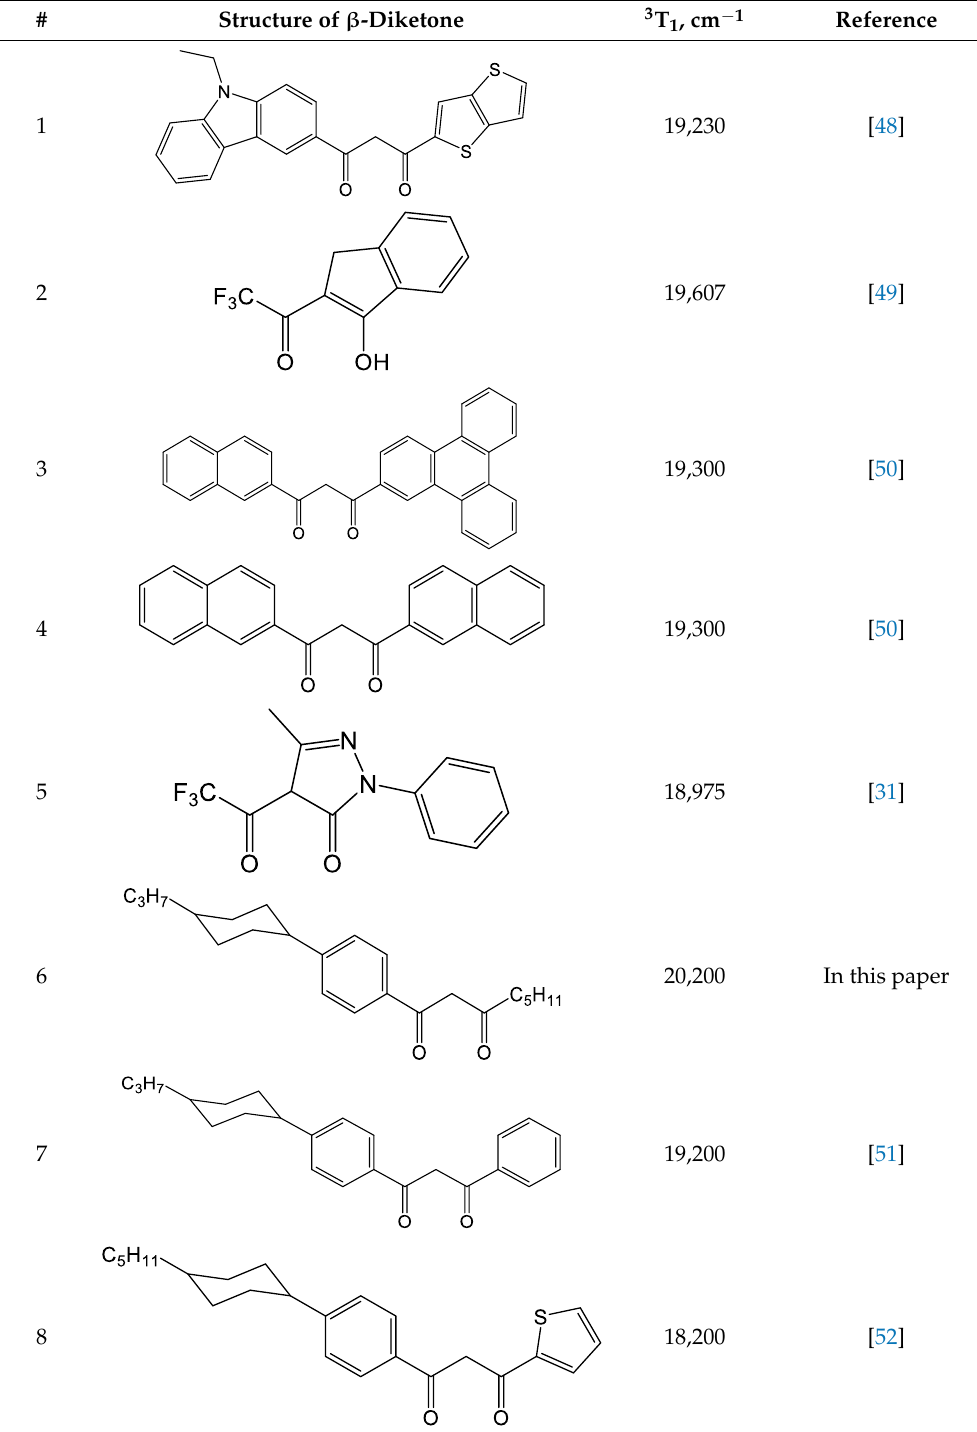
Table 1. Structures and triplet levels of some β -diketones.